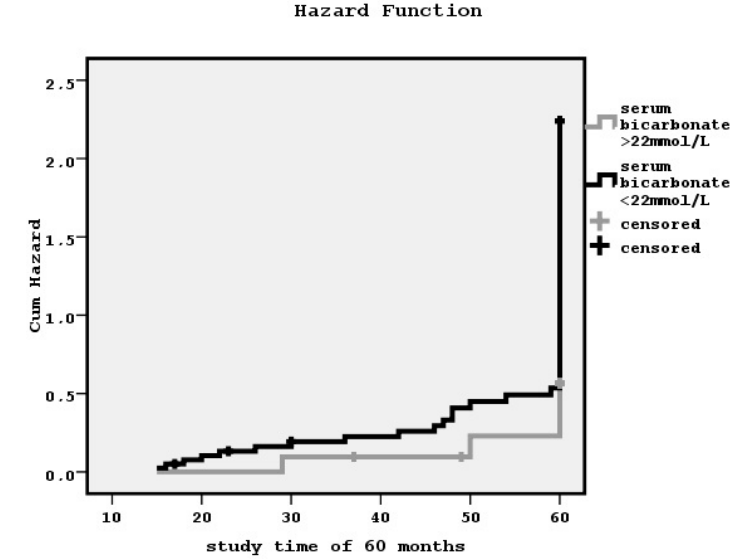
Figure 3. The impact of lower or higher than 22 mmol/L serum bicarbonate levels on diastolic dysfunction during a follow-up time of 60 months by the Kaplan–Meier curve (log-rank = 5.84, p = 0.01).